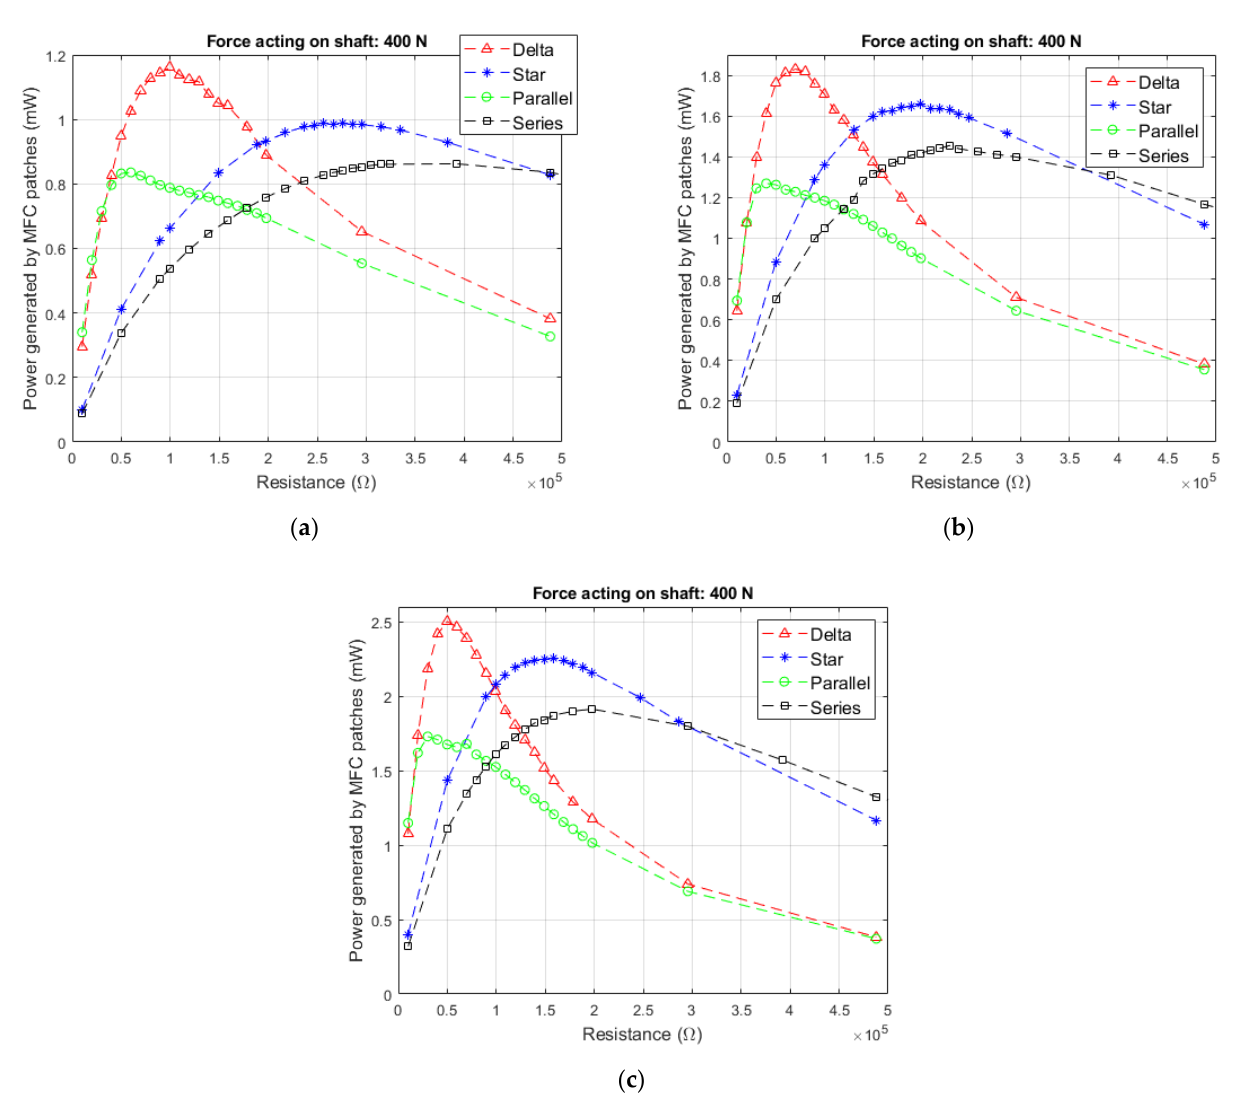
Figure 9. Electrical power generated for a force equal to 400 N: ( a ) rotational speed equal to 10 rps; ( b ) rotational speed equal to 15 rps; and ( c ) rotational speed equal to 20 rps.